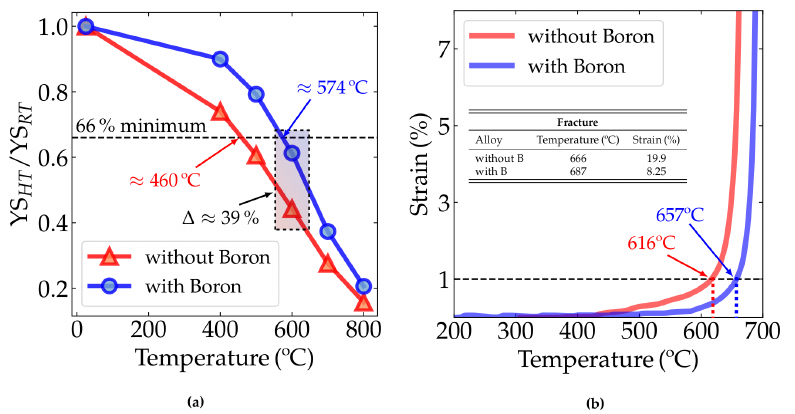
Figure 4. ( a ) Yield strength ratio of the alloys without boron (alloy 1) and with boron-added (alloy 2) at room temperature (RT or 25 °C), 400, 500, 600, 700 and 800 °C; minimum threshold indication of 66% for yield strength ratio at 600 °C with their respective values. ( b ) Plastic strain with temperature from transient test data—heating rate: 5 °C/min, preload applied: 188 MPa (equivalent to 33% YSRT for alloy 1-without B and 36% YSRT for alloy 2-with